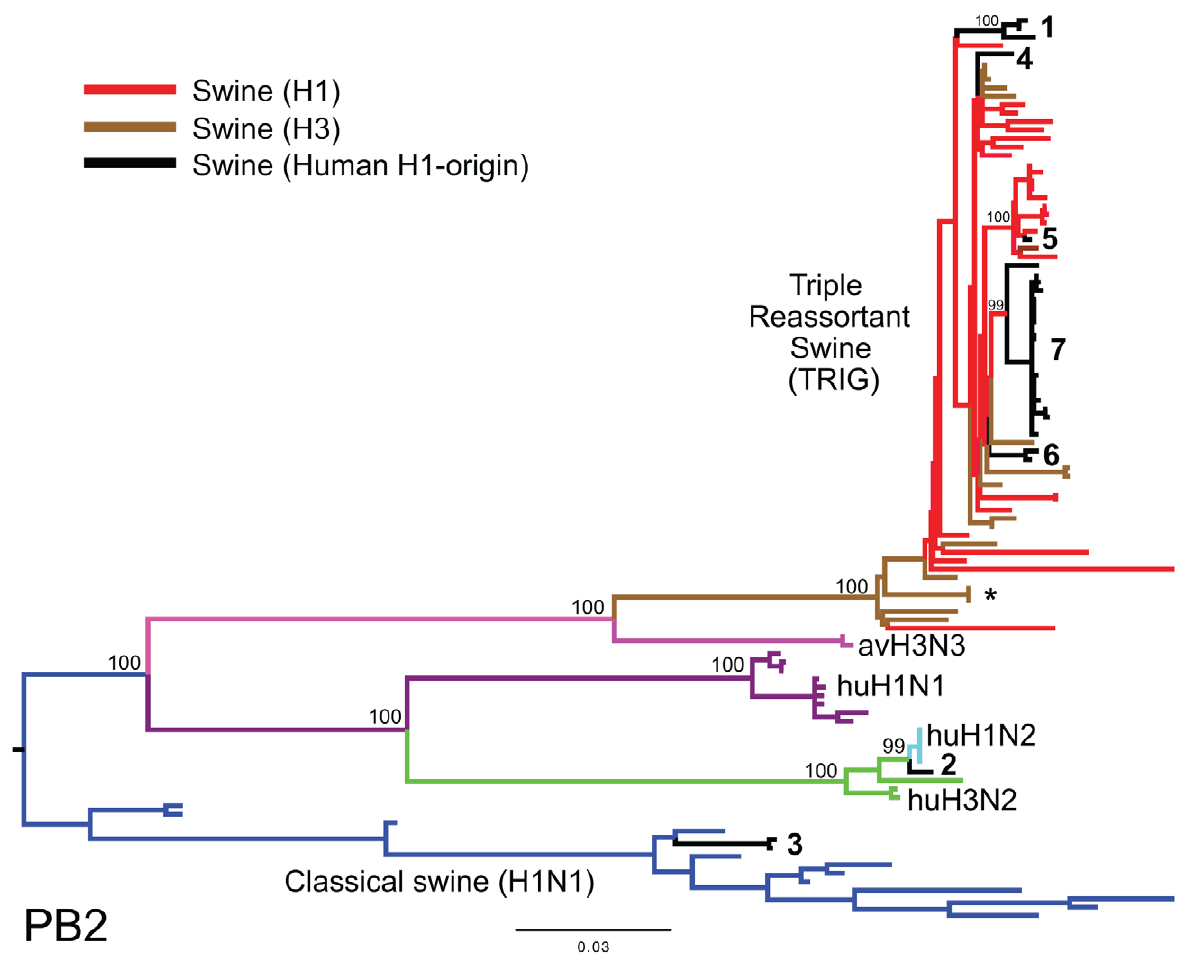
Figure 3. Phylogenetic relationships of the PB2 segment. Phylogenetic relationships of the PB2 segment (2,277 nt) of the 31 human H1-origin swine influenza viruses for which whole-genome sequences are available (2003–2008) and, as background, 12 classical swine isolates (1931–2004), triple reassortant swine viruses of H3 (n=18) and H1 (n=26) subtypes (1998–2009), 2 avian-H3N3 origin swine isolates, and 15 representative H3N2, H1N2, and H1N1 human influenza isolates. The maximum likelihood tree is mid-point rooted for clarity, and all branch lengths are drawn to scale. Bootstrap values . 70% are included for key nodes. Shading of branches, according to evolutionary origins of tip isolate, is similar to those used in Table 1: black = human H1-origin swine influenza viruses, purple = human H1N1, green = human H3N2, light blue = human H1N2, blue = classical swine influenza viruses, pink = avian H3N3-origin swine isolates, red = triple reassortant swine influenza viruses (H1), and brown = triple reassortant swine influenza viruses (H3). Numbers associated with human-origin swine influenza viruses also correspond to those listed in Table 1: 1= A/sw/IL/ 00685/2005(H1N1), A/sw/NC/00573/2005(H1N1), and A/sw/Minnesota/07002083/2007(H1N1); 2= A/sw/Ontario/52156/2003(H1N2); 3= A/sw/ Ontario/48235/2004(H1N2) and A/sw/Ontario/55383/2004(H1N2); 4= A/sw/Minnesota/SG-00239/2007(H1N2); 5= A/sw/IL/07003243/2007(H1N2); 6= A/sw/Texas/008648/2008(H1N2) and A/sw/Texas/01976/2008(H1N2); and 7= a cluster of 21 human H1N2-origin influenza viruses, represented by A/sw/Oklahoma/010226-16/2008(H1N2) (listed in Table S6). The asterisk denotes the first triple reassortant swine influenza viruses identified in